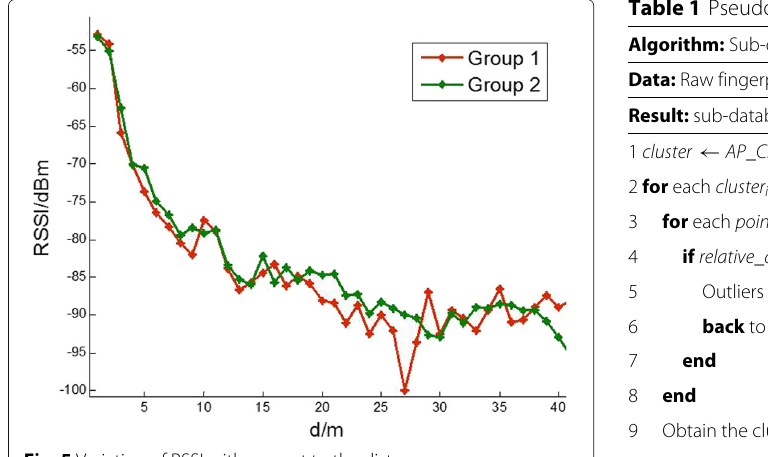
Fig. 5 Variation of RSSI with respect to the distance